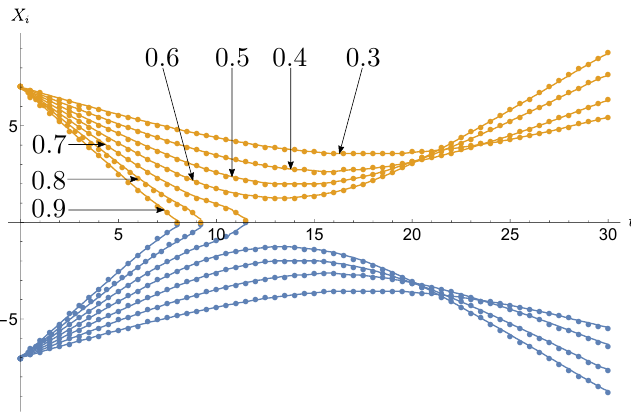
Figure 37 . Trajectories for non-Abelian vortex-antivortex head-on scatterings of type I*, with initial velocities u = 0 . 3 , 0 . 4 , · · · , 0 . 9 (marked on the plots for clarity). In all cases, Y i ( t ) = 0 at all times. The curves for u = 0 . 7 , 0 . 8 , 0 . 9 are truncated before the end of the simulation ( t = 30 ) because the vortex-antivortex pair annihilates during the